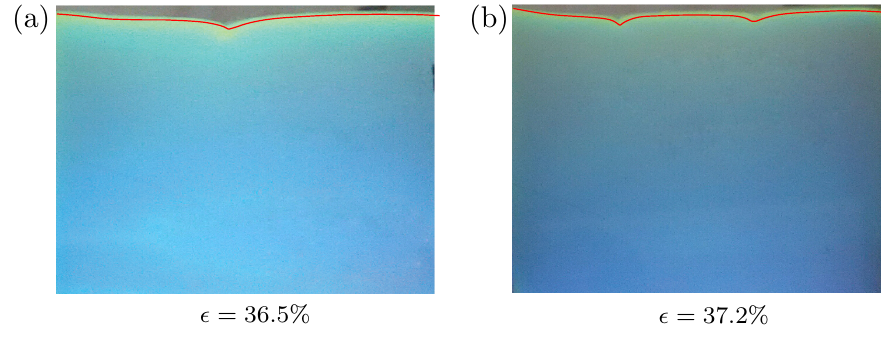
Figure 3. Creasing pattern for a cuboid silicone rubber under the uniaxial compression and plane strain conditions. ( a ) a single crease at engineering compressive strain 36.5%; ( b ) double creases at engineering strain 37.2%. The silicone rubber does not experience cyclic loadings before the uniaxial compression.